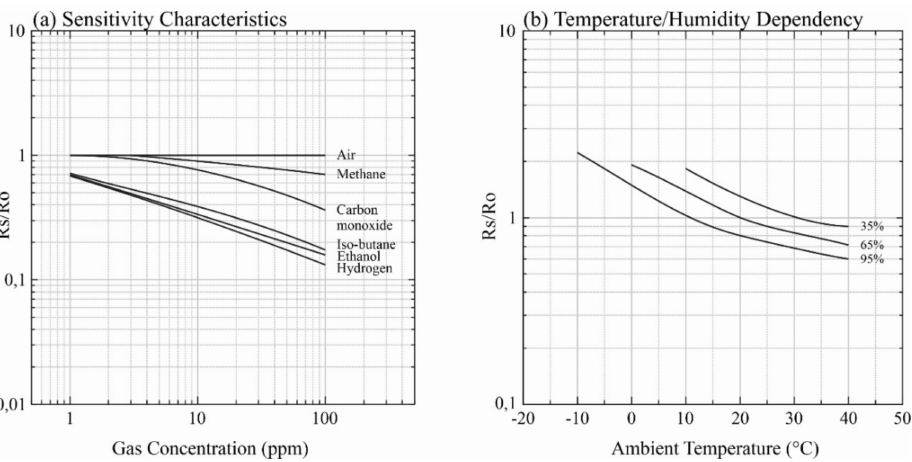
Figure 2. ( a ) Response of the Figaro TGS 2600 sensor to different gases; ( b ) Dependency of the Figaro TGS 2600 on temperature and relative humidity, where R s is the resistance of the sensor to different concentrations of the target gas and R 0 the resistance of the sensor in fresh air at 20 ◦ C and 65% RH. adapted from [25].